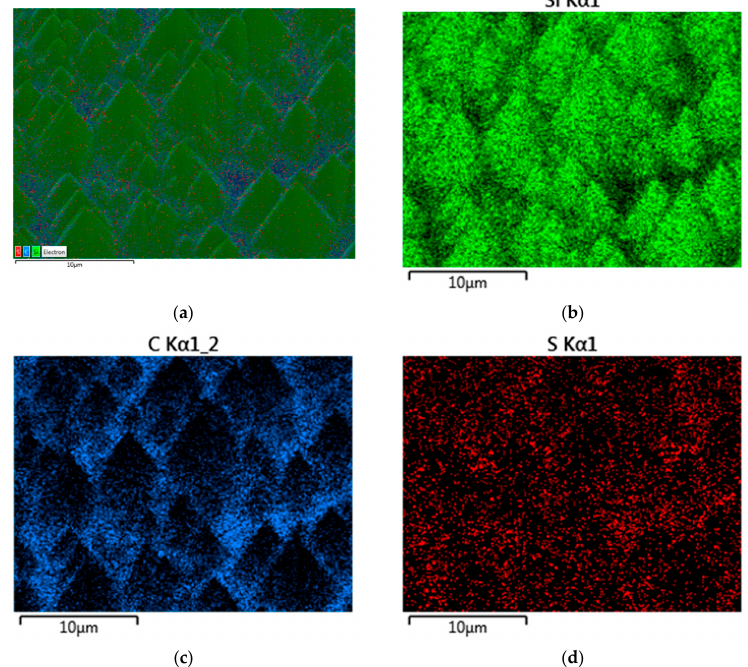
Figure 2. ( a ) The composite XEDS image of PEDOT:PSS solution spun on textured Si wafers ( b ) Si K α 1 component peaks ( c ) C K α 1_2 component peaks, showing an accumulation of carbon in the valleys between the pyramids ( d ) S K α 1 peaks show a similar accumulation in the valleys, but a lower image contrast is visible.